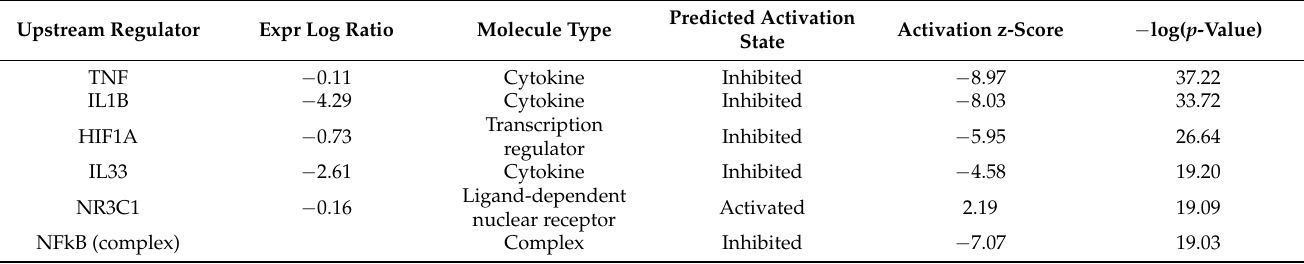
Table 4. Upstream regulator list by IPA for w/ TNF α dataset.